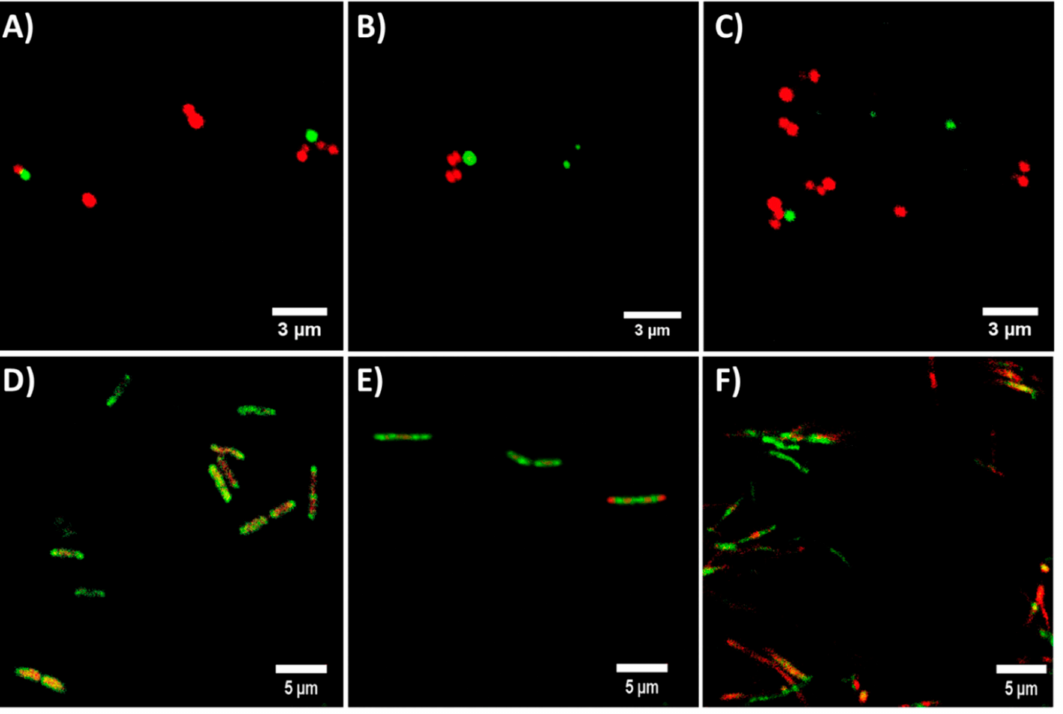
Figure 3. Confocal microscopy images of S. aureus ( A – C ) and E. coli ( D – F ) treated with the MIC of carvacrol ( A , D ), cinnamaldheyde ( B , E ) and thymol ( C , F ), stained with the Live/Dead ® BacLight™ bacterial viability kit. Red staining displays membrane damage.